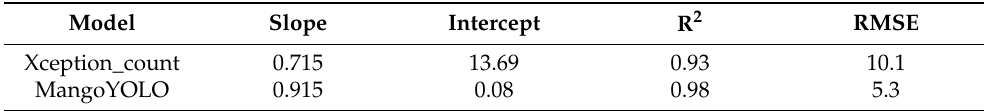
Table 5. Linear regression statistics for fruit count using the Xception_count model against the Table 6. Linear regression statistics for fruit count of 2018 tree images of orchard A (17 trees, 34 images) MangoYOLO model for tree images for orchard A (988 images of 494 trees) for 2 seasons. Units for by Xception_count and MangoYOLO models developed using 2017 data, against human count of intercept and RMSE are # fruit/image. fruit on images. Units for intercept and RMSE are #